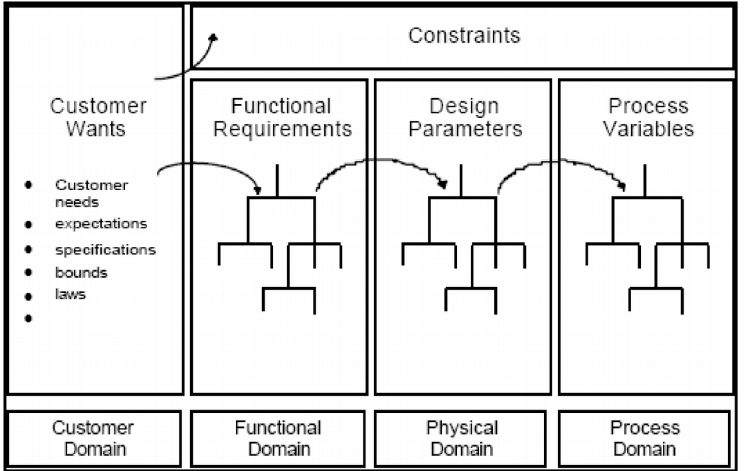
Figure 2. All design can be represented in four domains (Suh,